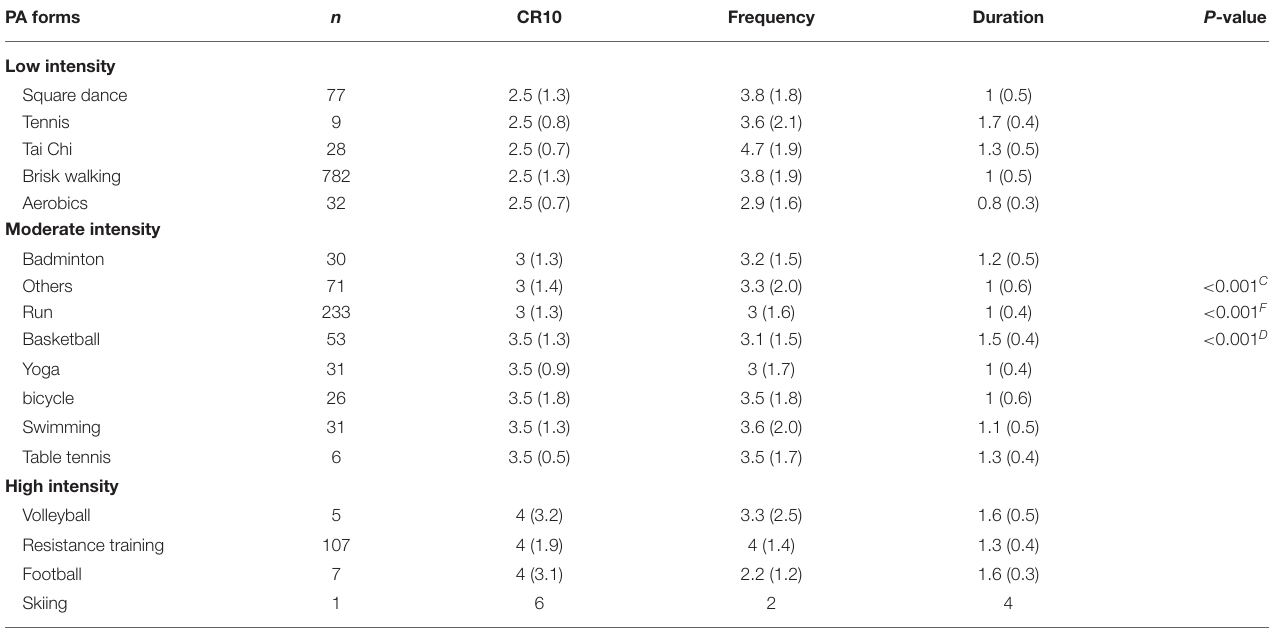
C Comparisons of CR10 among groups are significant with P-value < 0.001. F Comparisons of frequency among groups are significant with P-value < 0.001. D Comparisons of duration among groups are significant with P-value < 0.001.